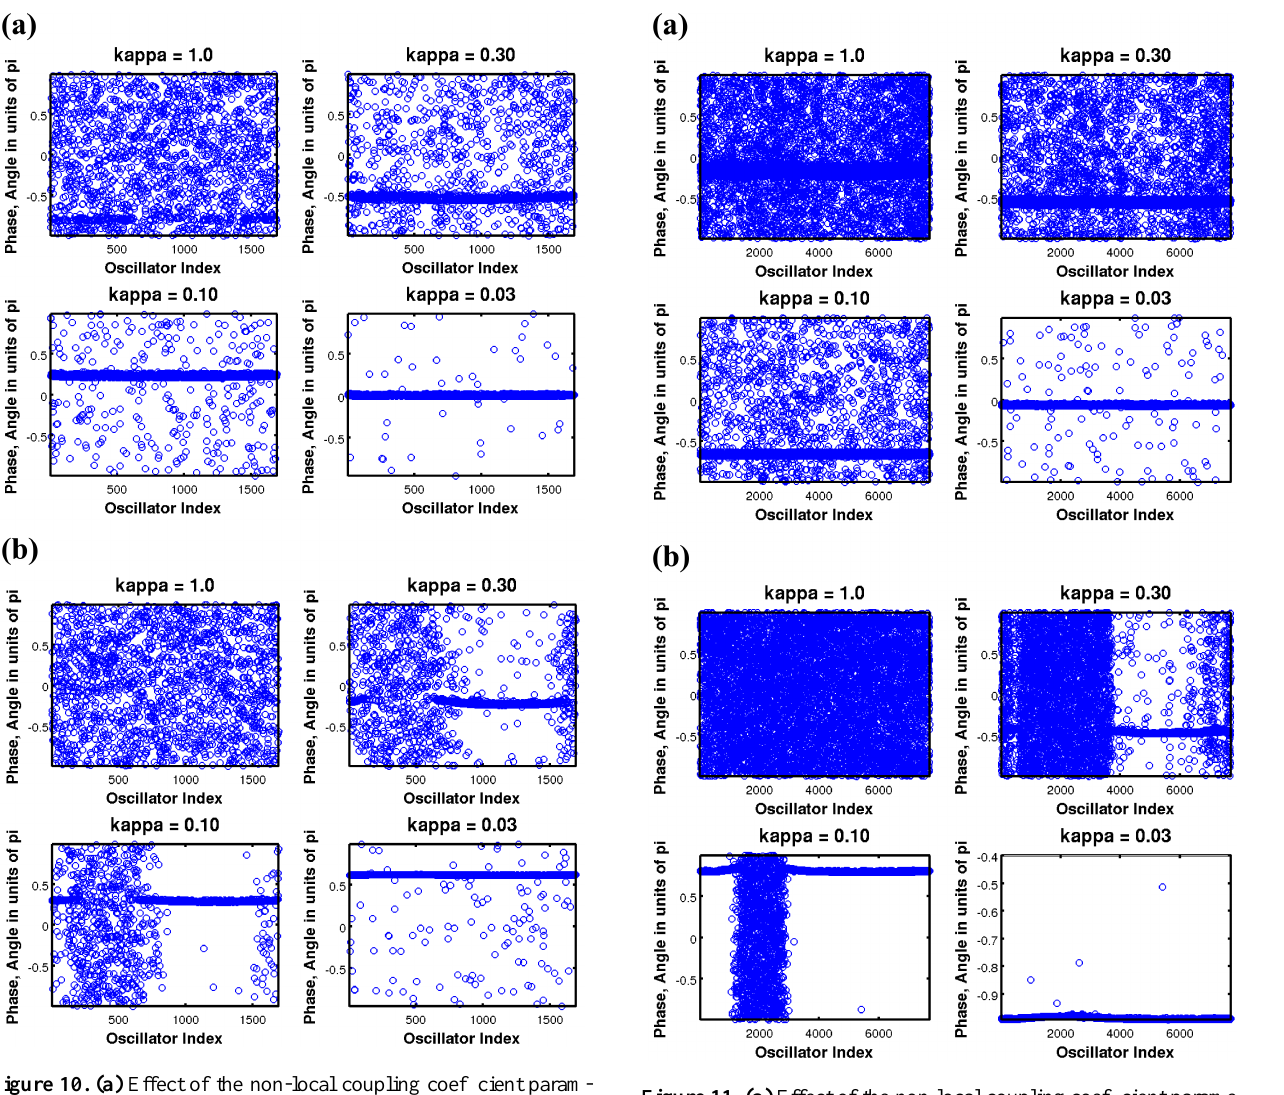
Figure 11. (a) Effect of the non-local coupling coefficient parame- ter, κ , on the evolution and disappearance of the chimera states for the 1024 × 1024 grid without recurrence. Stationary phase angle as a function of the oscillator index: kappa, κ = 1.0 (top left panel); kappa, κ = 0.3 (top right panel); kappa, κ = 0.1 (bottom left panel); kappa, κ = 0.03 (bottom right panel). (b) Effect of the non-local coupling coefficient parameter, κ , on evolution and disappearance of the chimera states for the 1024 × 1024 grid with recurrence. Sta- tionary phase angle as a function of the oscillator index: kappa, κ = 1.0 (top left panel); kappa, κ = 0.3 (top right panel); kappa, κ = 0.1 (bottom left panel); kappa, κ = 0.03 (bottom right